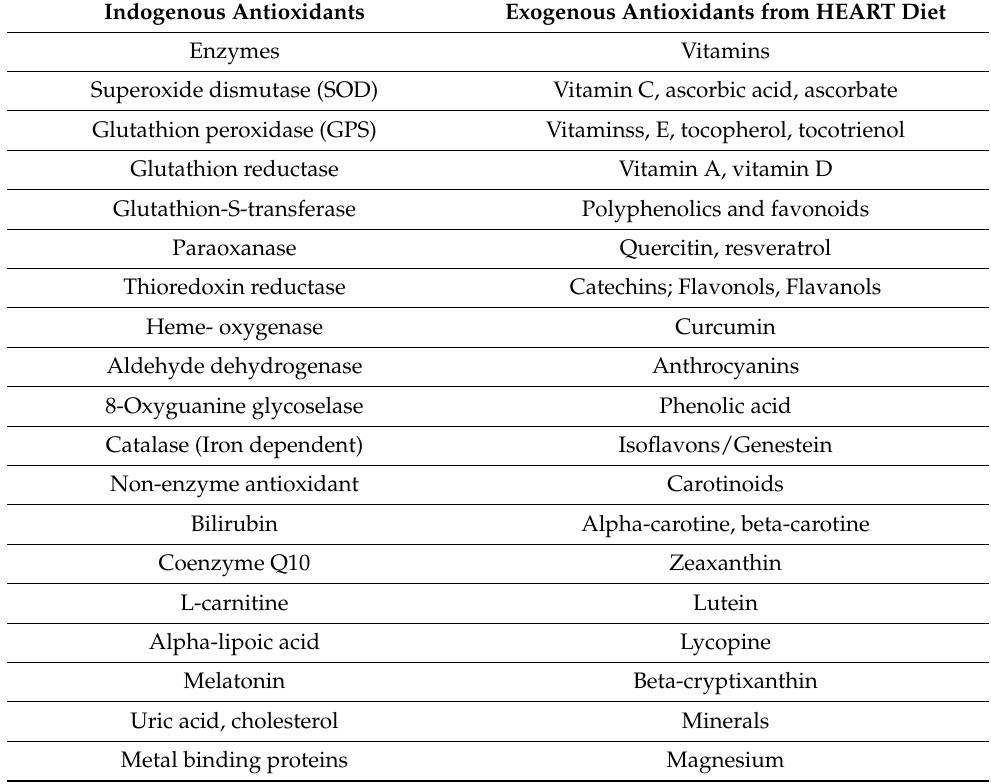
Table 2. Antioxidant defences and antioxidants available in the HEART diet.